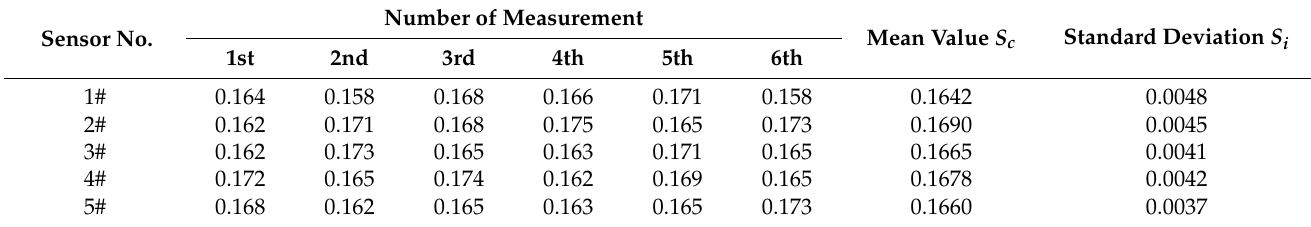
Table 1. List of detection values and their standard deviations for each sensor at point C (mm).